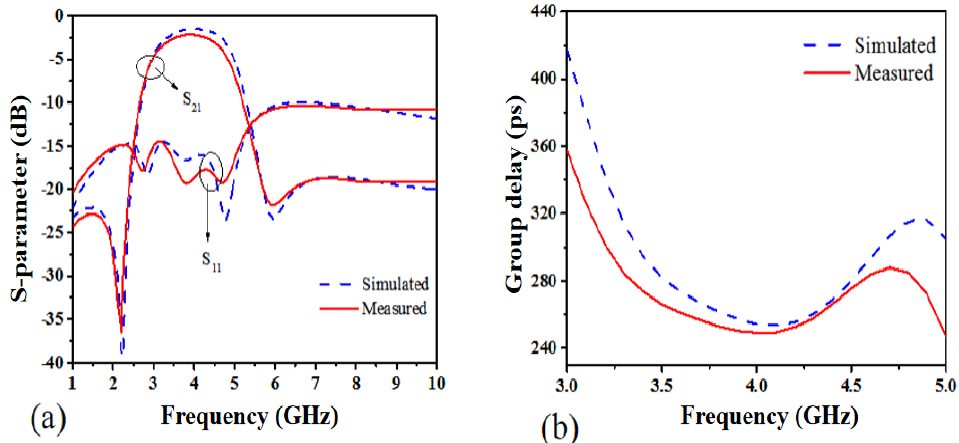
Figure 5. Simulated and measured results of proposed reflectionless band-pass filter. ( a ) S parameter. ( b ) Group delay.